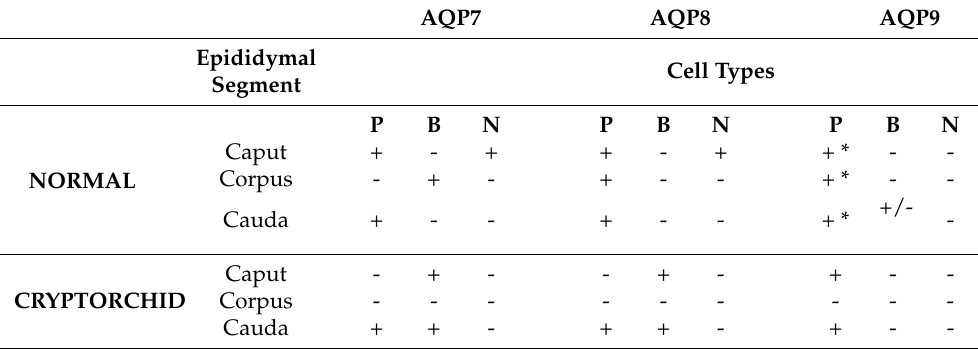
Table 3. Cellular distribution of AQP7, 8, and 9 in the epididymis of normal and cryptorchid